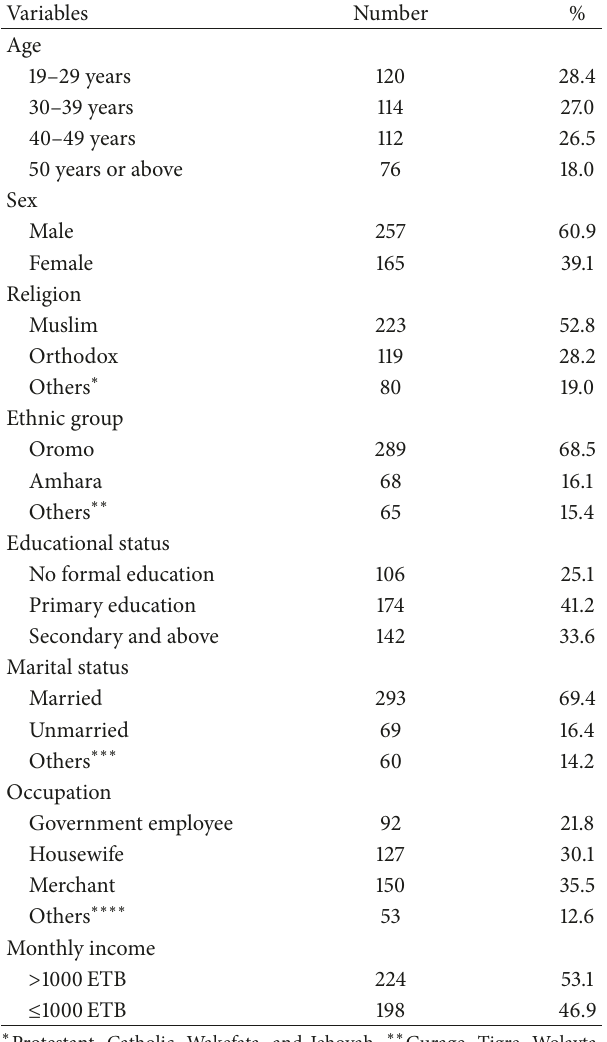
Table 1: Sociodemographic characteristics of the sampled (𝑛 = 422) adults in Jimma town, southwest Ethiopia,